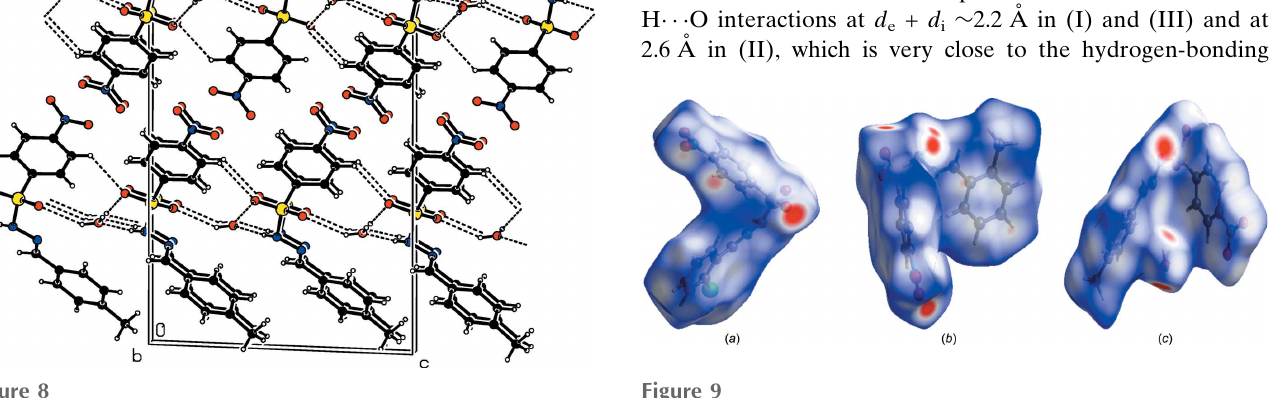
Figure 9 View of the Hirshfeld surface mapped over d norm for ( a ) (I), ( b ) (II) and ( c )